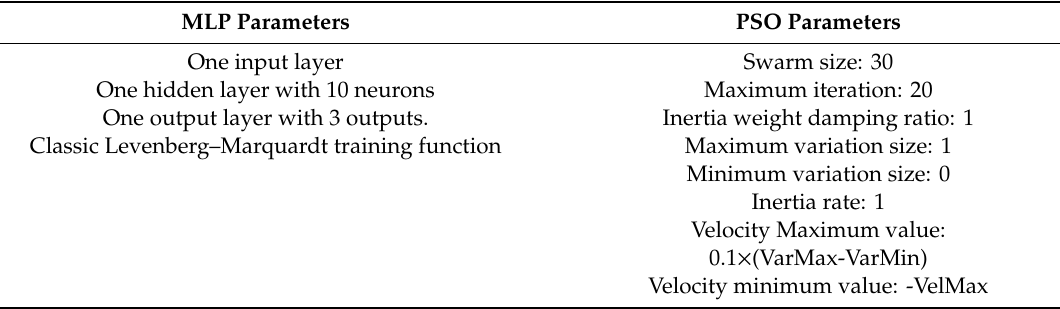
Table 1. The parameters of the multi-layer perception (MLP) and particle swarm optimization (PSO) for the hybrid artificial neural network (ANN)-PSO for selecting the most significant